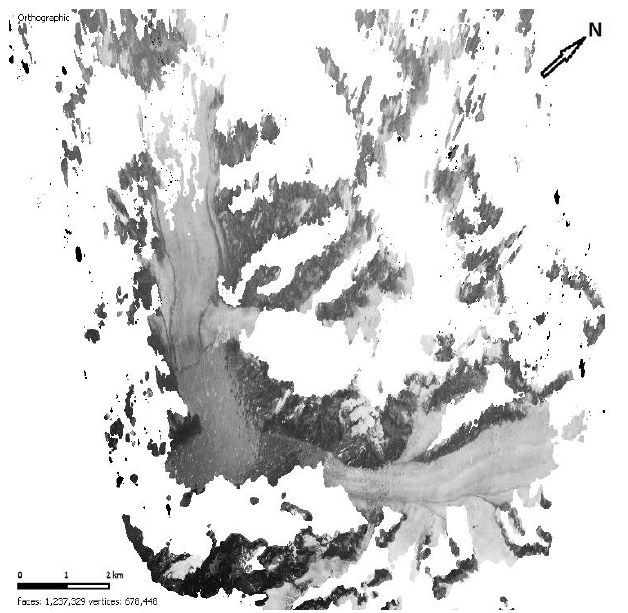
Figure 18. An orthographic view of the 3D model shows glacier mouths; it can be joined with satel- lite and drone images. Unfortunately, the images were taken at a low angle oblique, which caused a considerable amount of hidden parts due to the perspective (white areas).